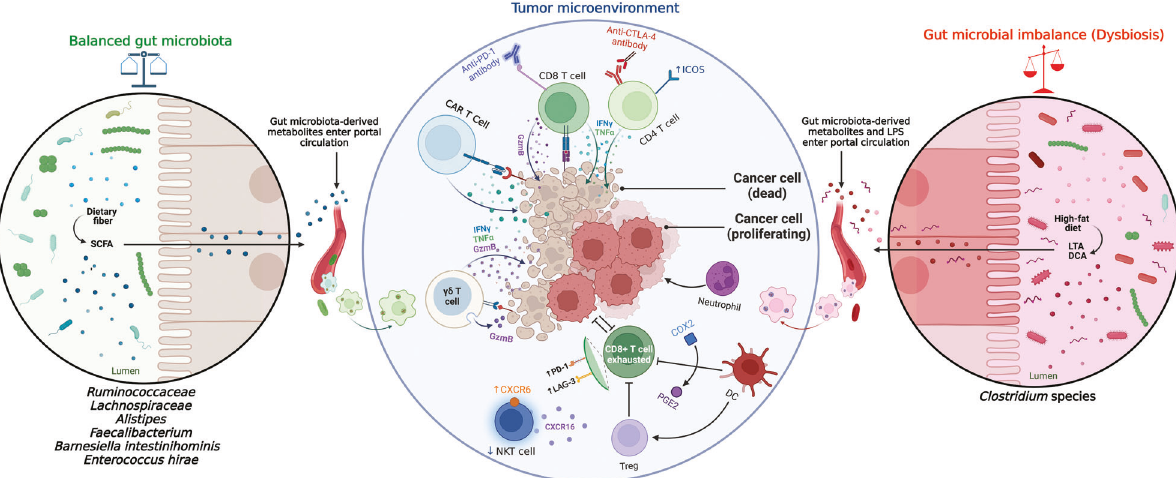
Fig. 1 Systemic impact of the gut microbiota on anti-tumor immunity. Interactions between the human microbiome and the immune system can contribute to tumor inhibition and/or tumor progression, via several mechanisms. In a balanced and healthy human gut microbiota and following suf fi cient dietary fi ber intake, bacterial metabolites such as SCFAs derived from gut bacteria can translocate from the gut lumen to blood and eventually regulate T cell immunity. For instance, SCFAs can play an important role in T cell activation by increasing the accumulation and in fi ltration of CD4 + , ICOS + and CD8 + T cells, enhance the expression of Gzm B, IFN- γ , and TNF- α , improve clinical responses to checkpoint blockade immunotherapies such as anti-PD-1/PD-L1 and anti-CTLA4 antibodies and CAR-T cell therapy, and recruitment of IFN- γ -producing γδ T cells in the TME, all contributing to enhanced anti-tumor immunity. On the opposite side, a gut microbiota imbalance (dysbiosis) induced by high-fat diet, including enrichment of Clostridium species, could potentially increase the production of secondary BAs like DCA and microbe-associated molecular patterns, (e.g., LTA and LPS) which can enter the circulation and then up-regulate COX2, induce an increase in PGE 2 , down-regulate CXCL16 production by liver sinusoidal endothelial cells and reduce recruitment of NKT cells, thus further contributing to tumor progression, and inhibit CD103 + dendritic cell, IFN- γ , and TNF- α accumulation and enhance tumor Treg accumulation thus contributing to cancer immune evasion. In addition, dysbiotic communities can contribute to hyper- stimulation of CD8 + T cells, promoting chronic in fl ammation and ultimately leading to T cell exhaustion (with expression of PD-1 and LAG-3), and in fi ltration of neutrophils that can inhibit anti-tumor immunity, which collectively contribute to the development of cancer. SCFA short chain fatty acid, ICOS inducible T cell co-stimulator, Gzm B Granzyme B, IFN- γ interferon gamma, TNF- α tumor necrosis factor α , PD-1 programmed death-1, PD-L1 programmed death-ligand 1, CTLA4 cytotoxic T-lymphocyte associated protein 4, CAR chimeric antigen receptor, γδ T cell gamma delta T cell, secondary BA secondary bile acid, DCA deoxycholic acid, LTA lipoteichoic acid, LPS lipopolysaccharide, COX2 cyclooxygenase-2, PGE2 prostaglandin E2, CXCL16 CXC motif chemokine ligand 16, NKT cell natural killer T cell, LAG-3 lymphocyte activation gene-3, DC dendritic